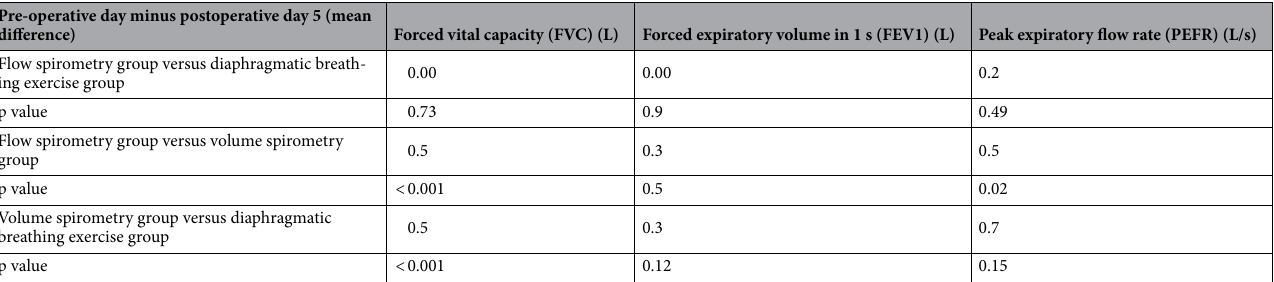
Table 5. Shows the difference between preoperative and postoperative day 5 between the three intervention groups of forced expiratory volume in 1 s (FEV1), forced vital capacity (FVC) and peak expiratory flow rate (PEFR). p < 0.001 highly significant.